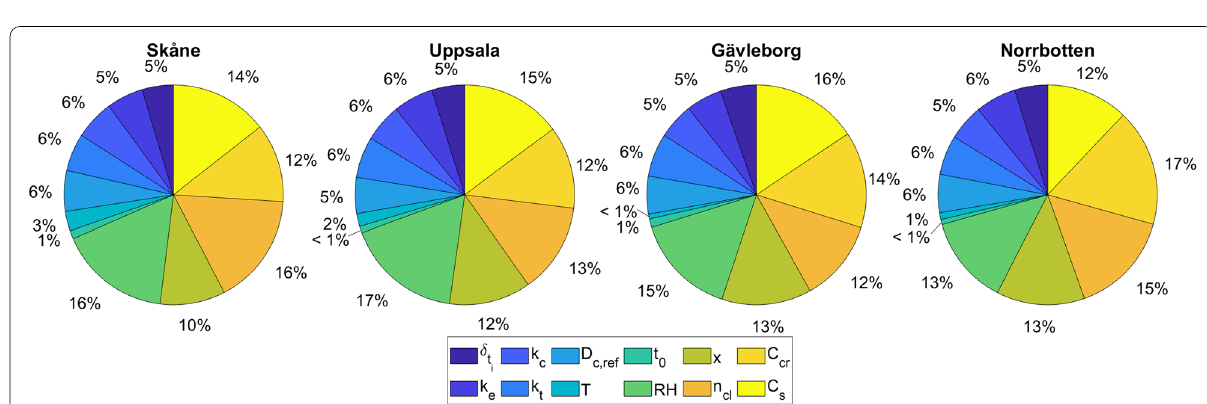
Fig. 11 The sensitivity of the end-of-century probability of corrosion initiation to the different input